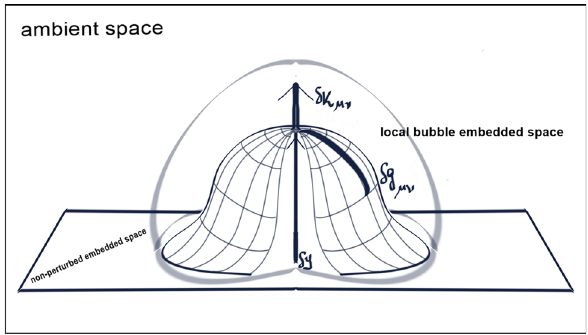
Fig. 1 A pictorial view of dynamical embedding in an ambient space. A “pith helmet” shaped-like surface emphasizes the embedding bubble formedinthelocalembeddedspace-timedeformedbytheperturbations of the y parameter. The tangent space is orthogonally deformed and the related cosmological perturbations can be studied with a chosen gauge in δ g μν ( 0 ) the perturbed metric g μν = g μν + δ g μν + δ 2 g μν + · · ·